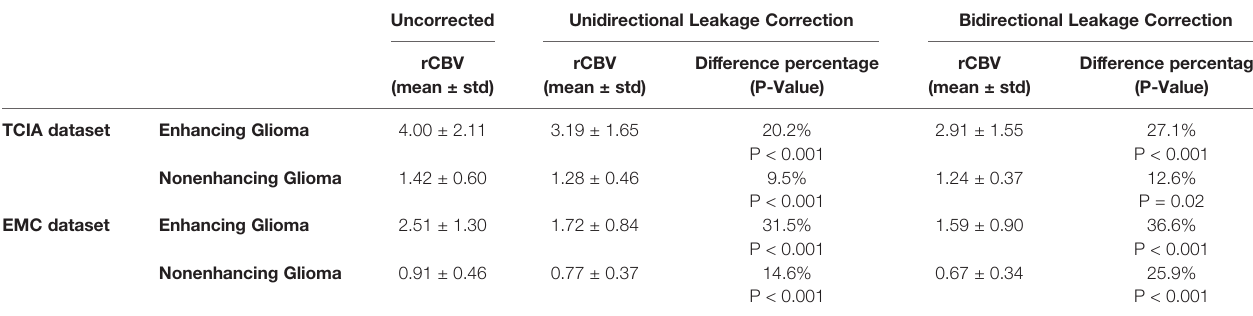
TABLE 2 | Patient averages of uncorrected and corrected rCBV and the resulting P-Value from statistical